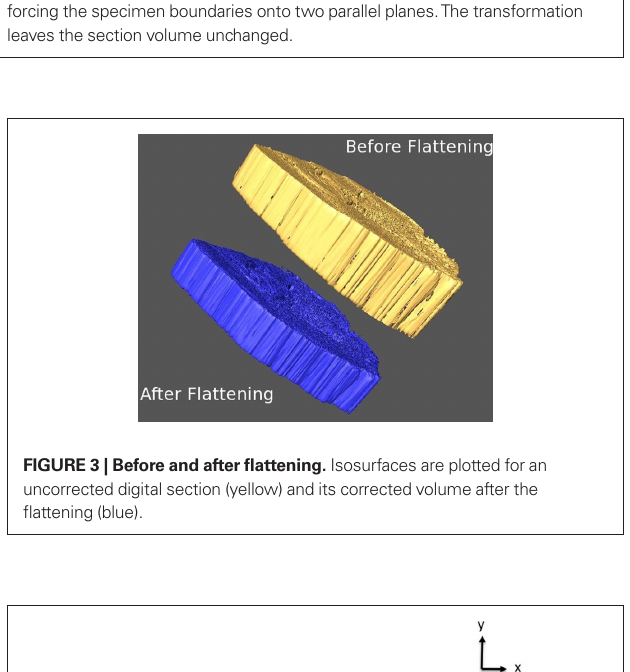
Figure 2 | Volume flattening process. (A) Isosurface of a single mouse brain coronal section. The two boundary surfaces are delimited by two sets of points (in green and in blue). This 3D plot clearly shows the section unevenness that is corrected for during the flattening step. (B) XYZ view of a warped mouse brain coronal section within the IMOD viewer. The volume density has been converted from RGB to gray scale. Two objects consisting of a set of points (respectively in green and in blue) model the spatial variation of the section